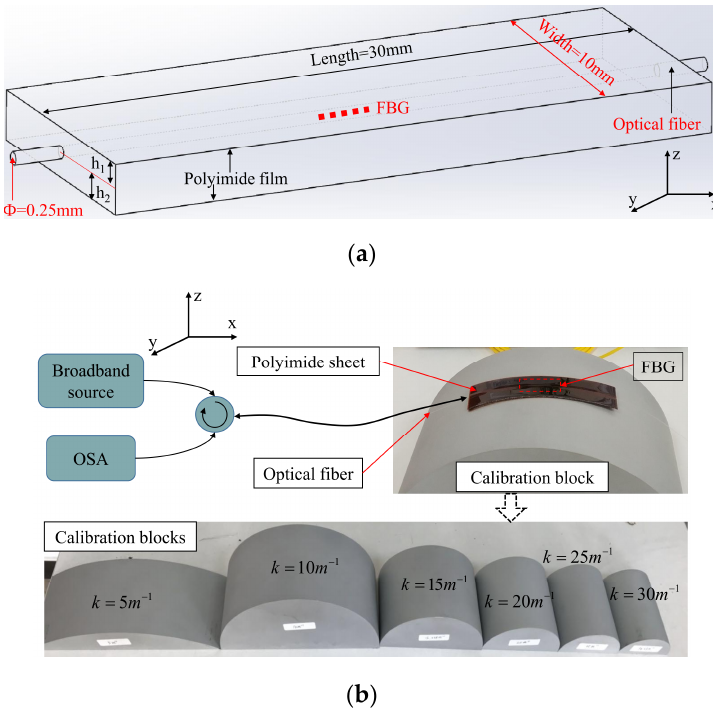
Figure 1. Physical layout of the optical fiber Bragg grating (FBG) sensor embedded in polyimide films. ( a ) Layout of the FBG sensor embedded in two polyimide films; ( b ) FBG sensor and its calibration blocks.